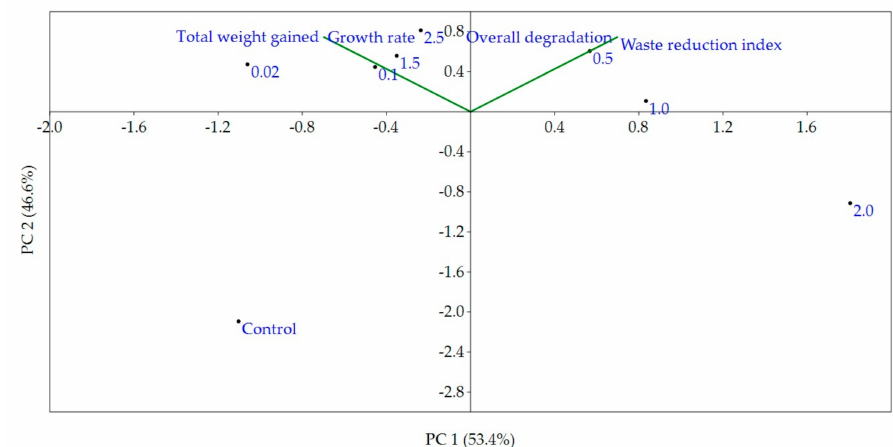
Figure 3. Principal component analysis of measurement variables under ex situ fermentation treatment mode (PC 1: eigen- value: 2.1355; variability: 53.38%; cumulative: 53.4%; PC 2: eigenvalue: 1.8664; variability: 46.61%; cumulative: